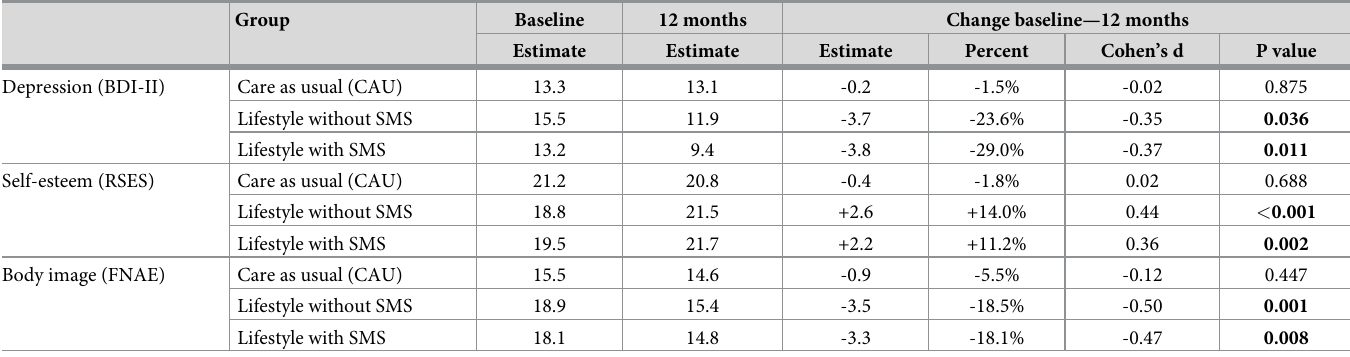
Table 3. Estimated depression, self-esteem and body image scores over time. Cohen’s D: 0.20 = small effect, 0.50 = medium effect and 0.80 = a large effect. Group Baseline 12 months Change baseline—12 months Estimate